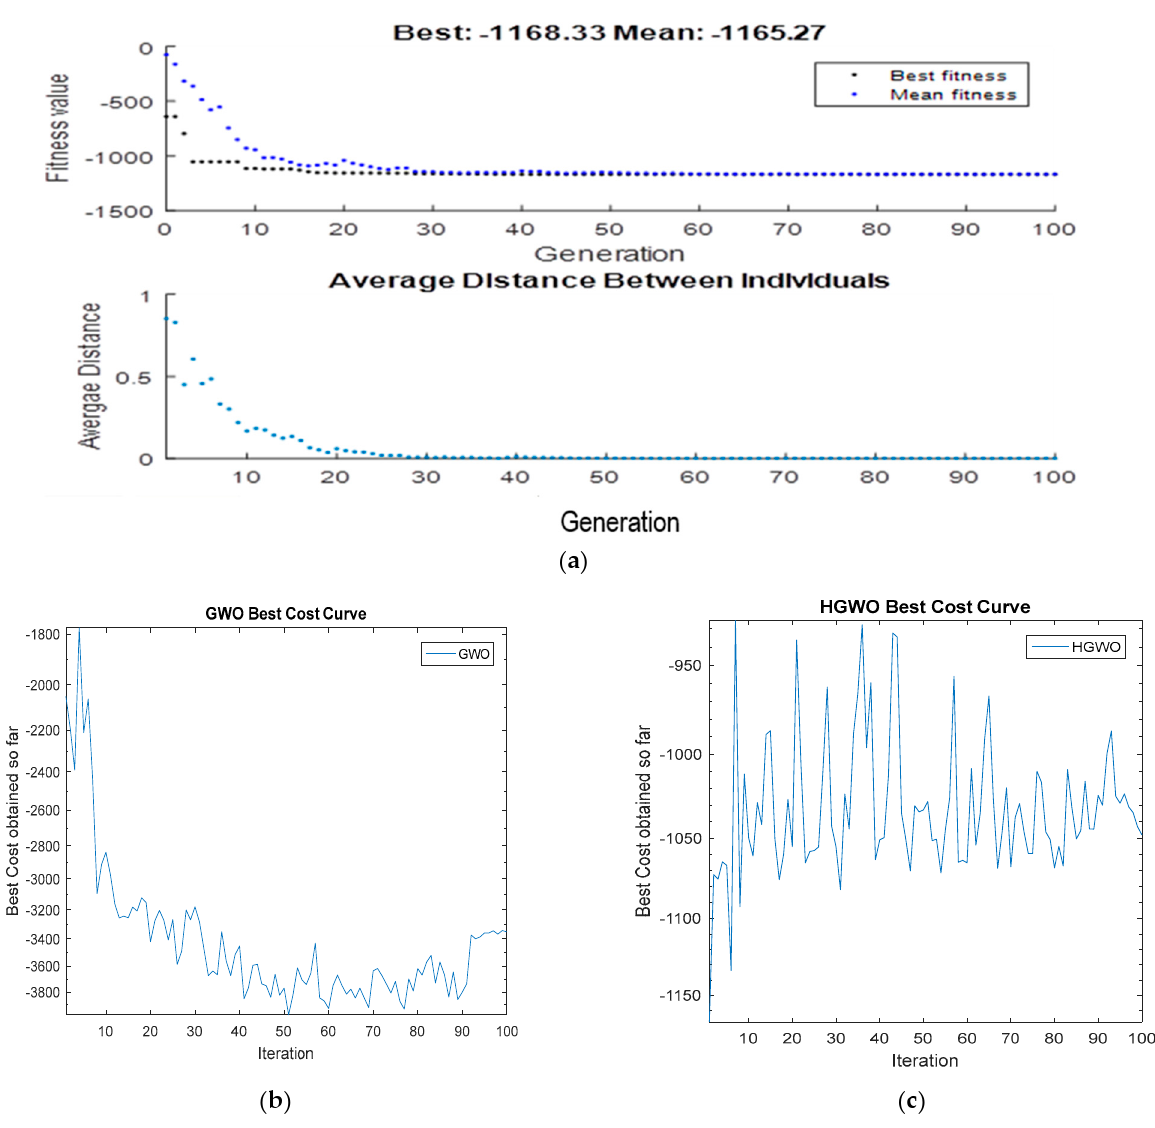
Figure 8. The cost graphs for cooperative path planning with: ( a ) GA; ( b ) GWO; ( c ) HGWO.